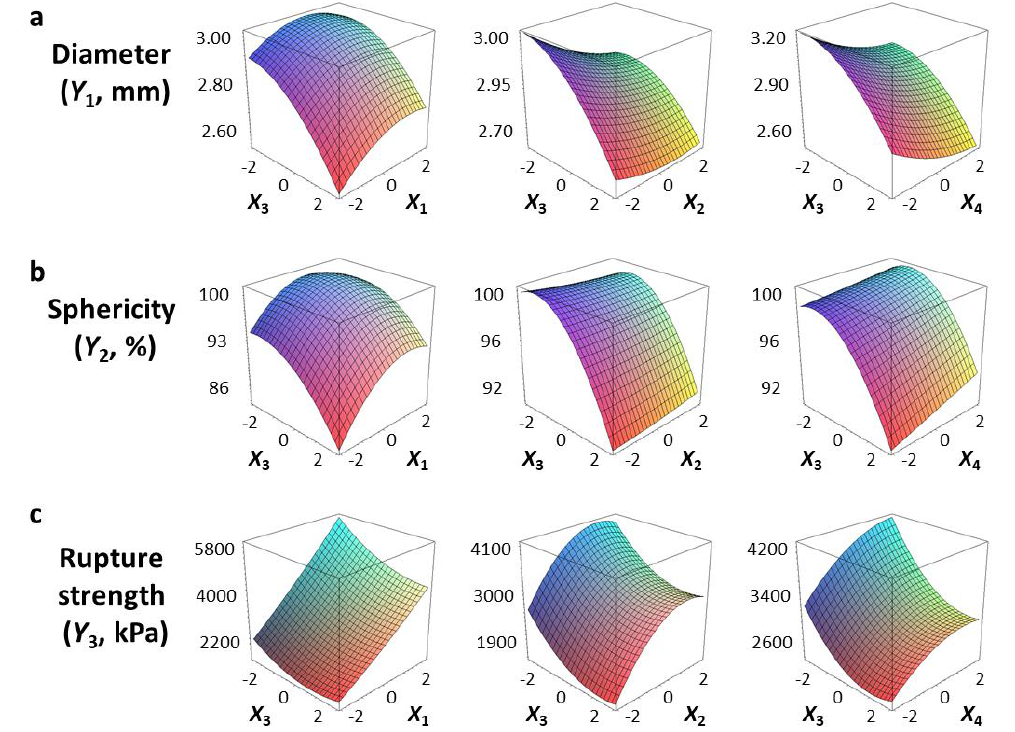
Figure 2. Three-dimensional response surface plots of the physical properties (( a ), Diameter; ( b ), Sphericity; ( c ), Rupture strength) of CAG beads. X 1 , sodium alginate concentration (%, w / v ); X 2 , calcium lactate concentration (%, w / v ); X 3 , gelation temperature ( ◦ C); X 4 , gelation time (min).